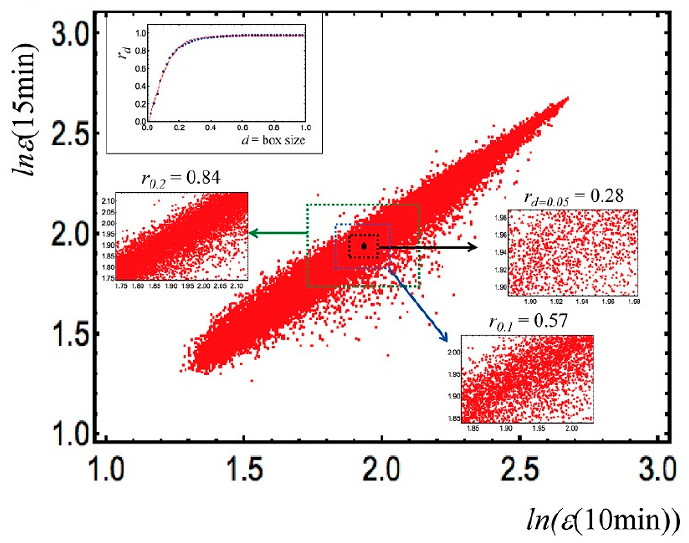
Figure 2. The axes of the figure correspond to the gene expression profile of two independent samples of the same cell kind (MCF 7 cancer cells). The vector points are the single gene expression levels expressed in logarithm units. The expression profiles are very strongly correlated across the whole genome (Pearson r = 0.98). Snapshots at smaller scale (d = range of variation) show progressive decrease in correlation with increasing detail (lower d). Top left inset shows the reaching of a plateau correlation at d = 0.5.